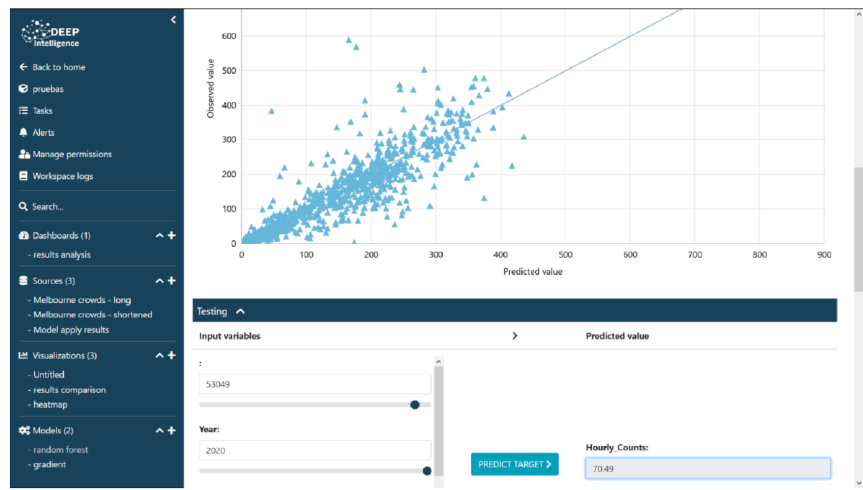
Figure 7. Predicted-observed diagram of the trained model and wizard for interactive predictions.